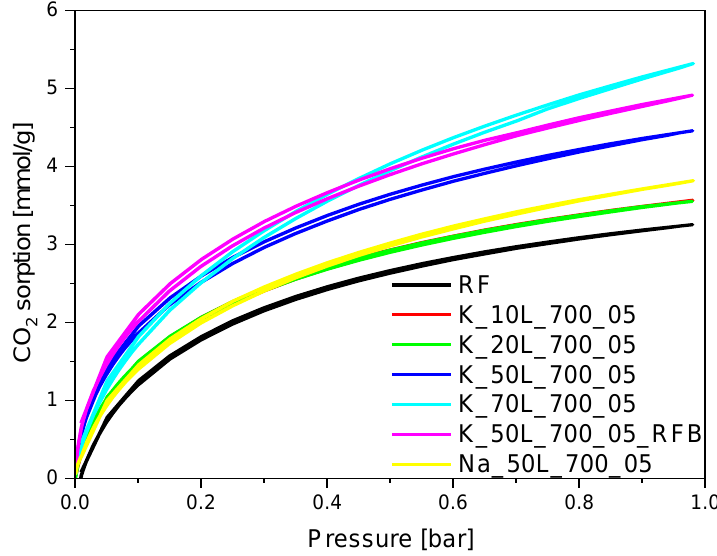
Figure 12. CO 2 sorption isotherms at 0 ◦ C of the samples activated using solution-based method with different KOH content and using different chemical activators.